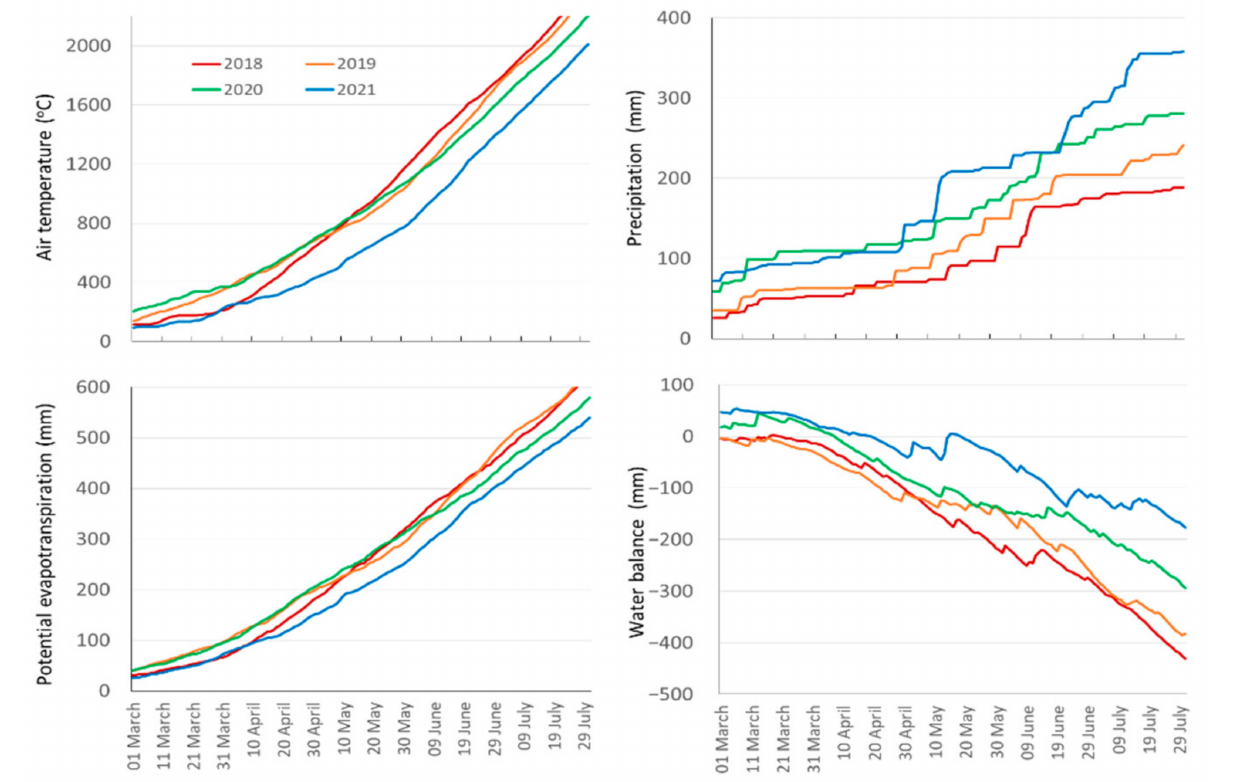
Figure 2. Temperature, precipitation, potential evapotranspiration and water balance, accumulated since 1 January of the given